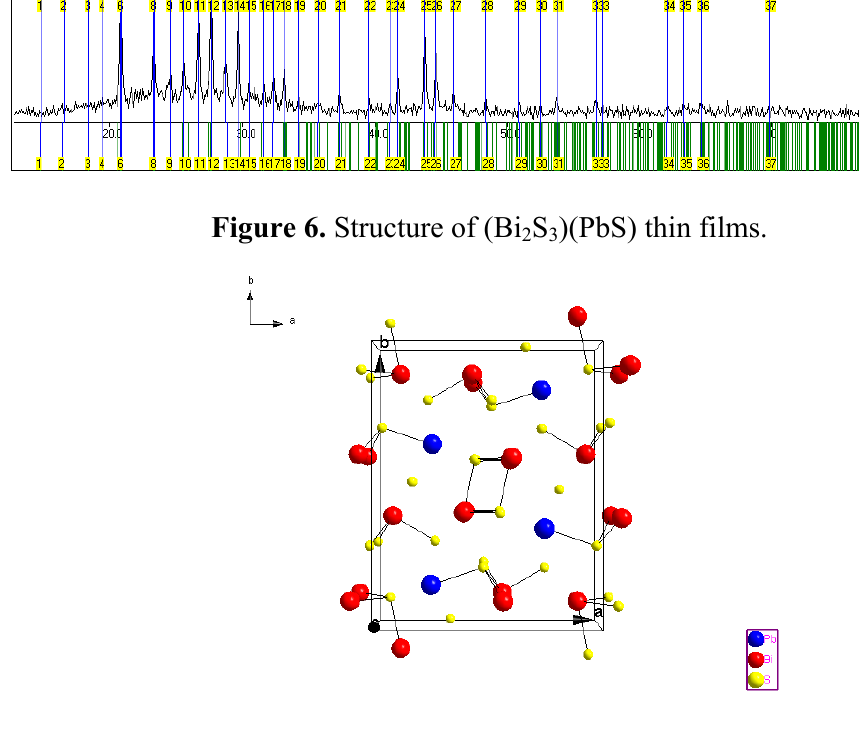
Table 3. Lattice parameters of (Bi